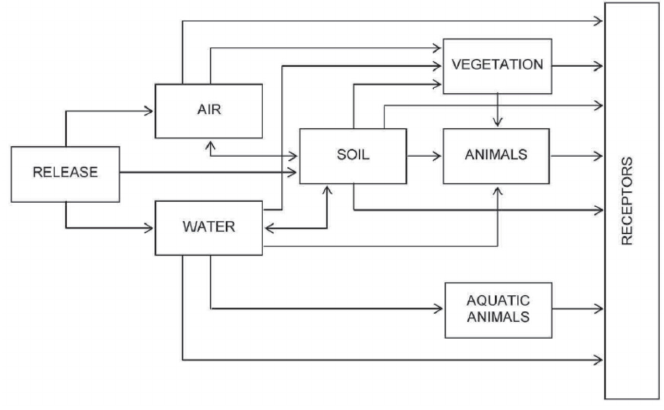
Figure 5. Generic environmental pathways and compartments (from [97]).